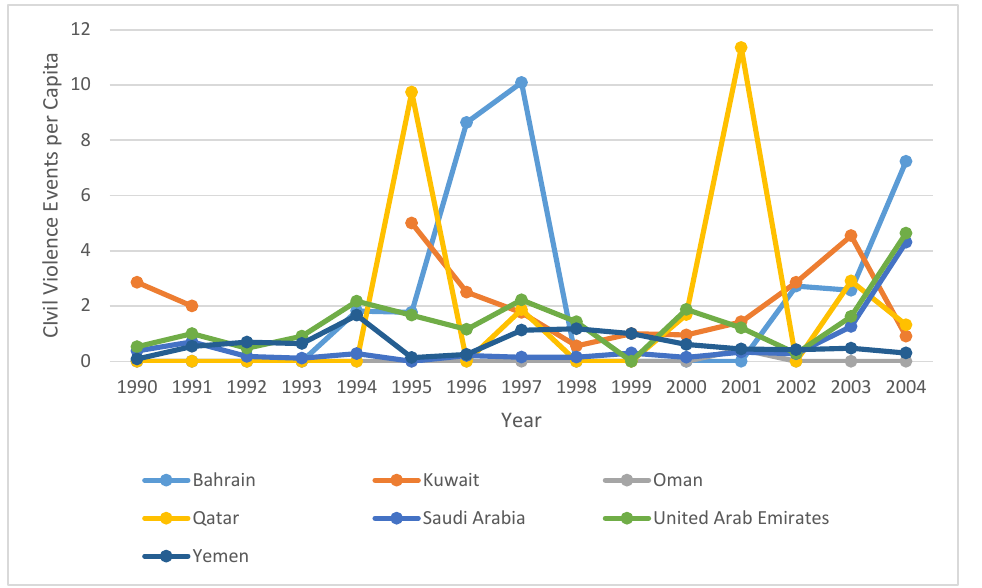
Figure 1. Civil Violence Events per Capita: Arab Gulf, 1990–2004.